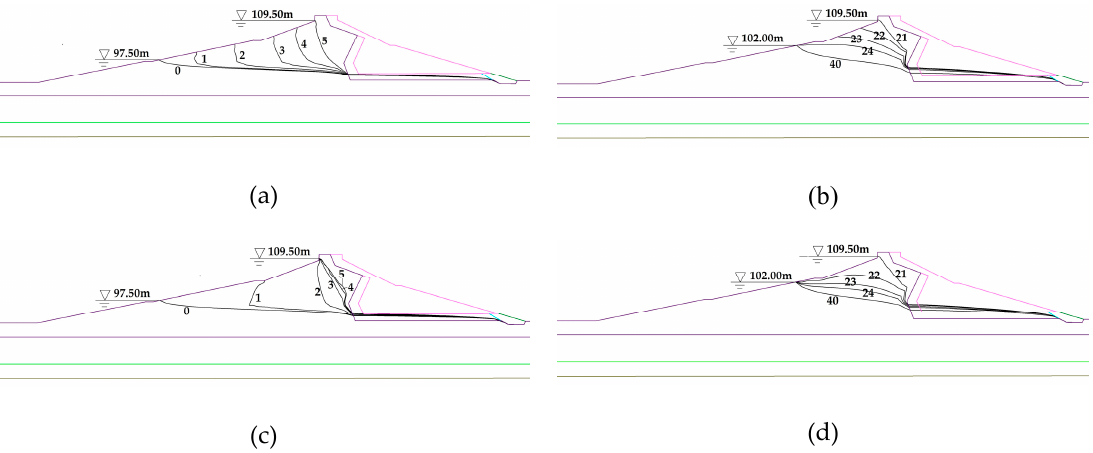
Figure 13. Phreatic line of the dam at representative moments (i.e., 5 indicates the fifth day of the simulation.) ( a ) Rising water level in condition I; ( b ) Falling water level in condition I; ( c ) Rising water level in condition II; ( d ) Falling water level in condition II.